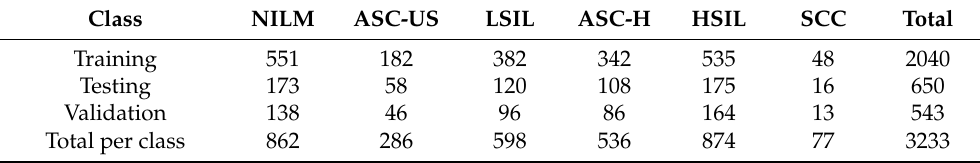
Table 1. The number of images from each class for the training, validation, and testing sets. Class NILM ASC-US LSIL